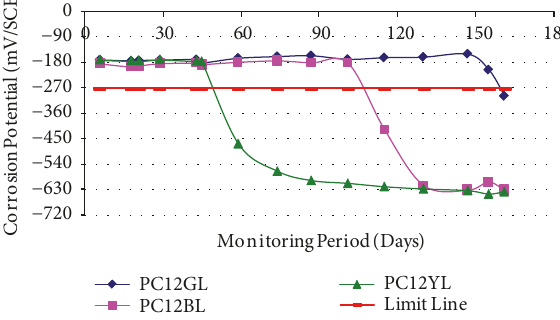
Figure 6: Log corrosion current densities versus time for PCDC at w/c 0.80.